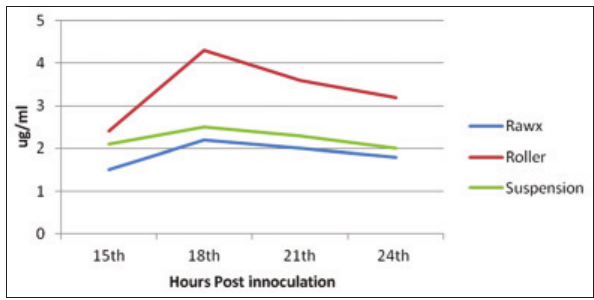
Figure-4: Effect of cell culture system on foot and mouth disease virus serotype (A) antigenicity (146S content) in baby hamster kidney-21 cell culture at 37°C.